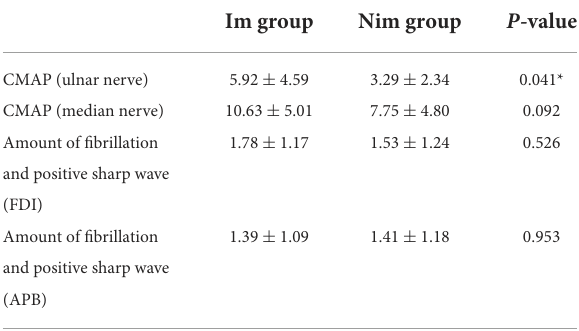
TABLE 3 Comparison of preoperative EMG data between the two groups of patients.